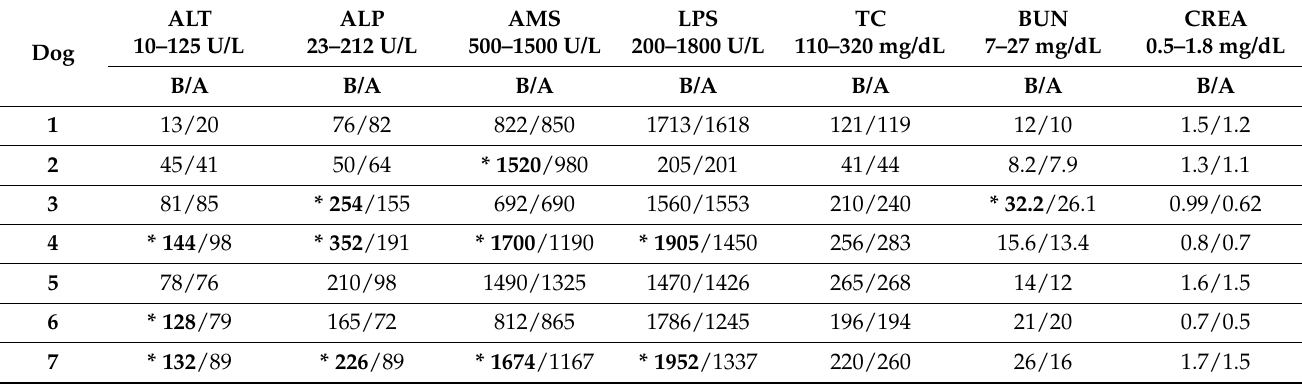
Table 4. Biochemical examination before ( B ) and after ( A ) therapy in the first group of